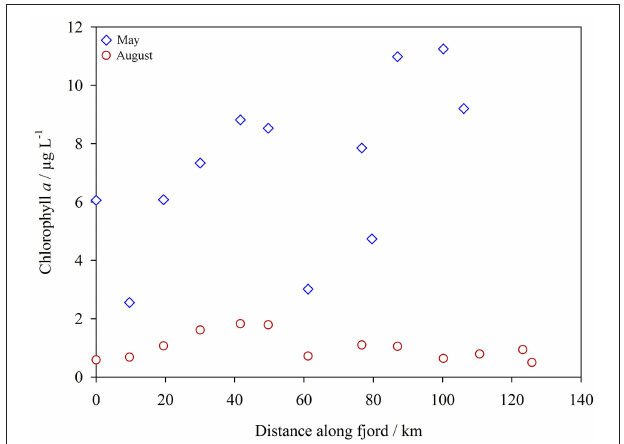
FIGURE 4 | Chlorophyll a in the surface waters of Godthåbsfjord, May (blue diamonds) and August 2014 (red circles). Plotted as distance from GF2.